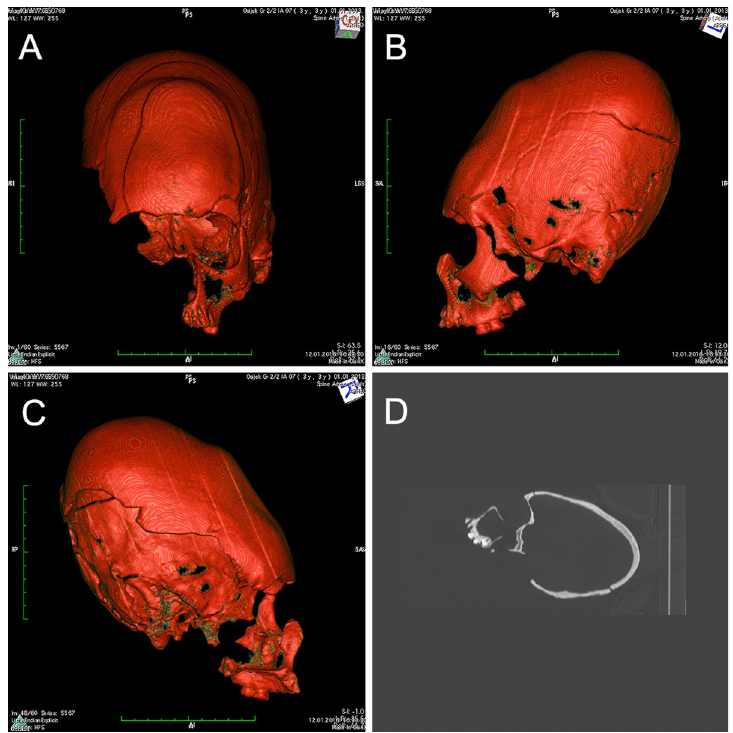
Fig 1. A-C) CT reconstruction showing the artificially deformed cranium belonging to individual SU 259, frontal and lateral views. The shape axis is dislocated posteriorly above the Frankfort horizontal plane while the cranium exhibits a depressed and strongly inclined frontal bone strongly indicating tabular oblique type of deformation. D) X-ray of the same cranium (lateral view) showing a significant thickening of the posterior